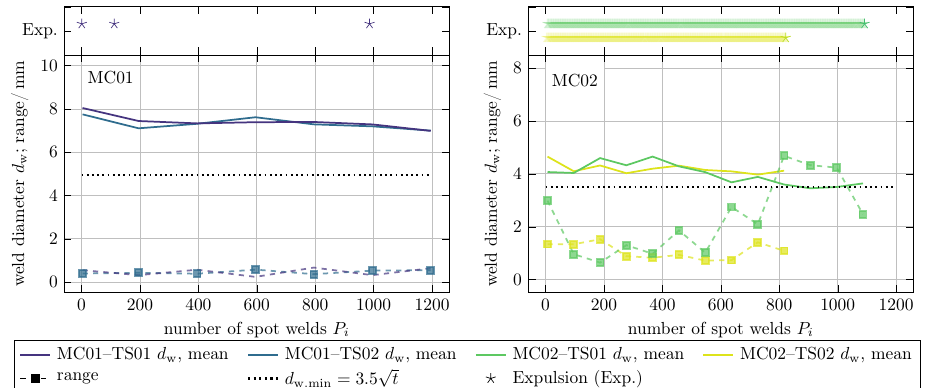
Figure 11. Development of weld diameter d w of MC01 and MC02 determined by destructive chisel test according to ISO